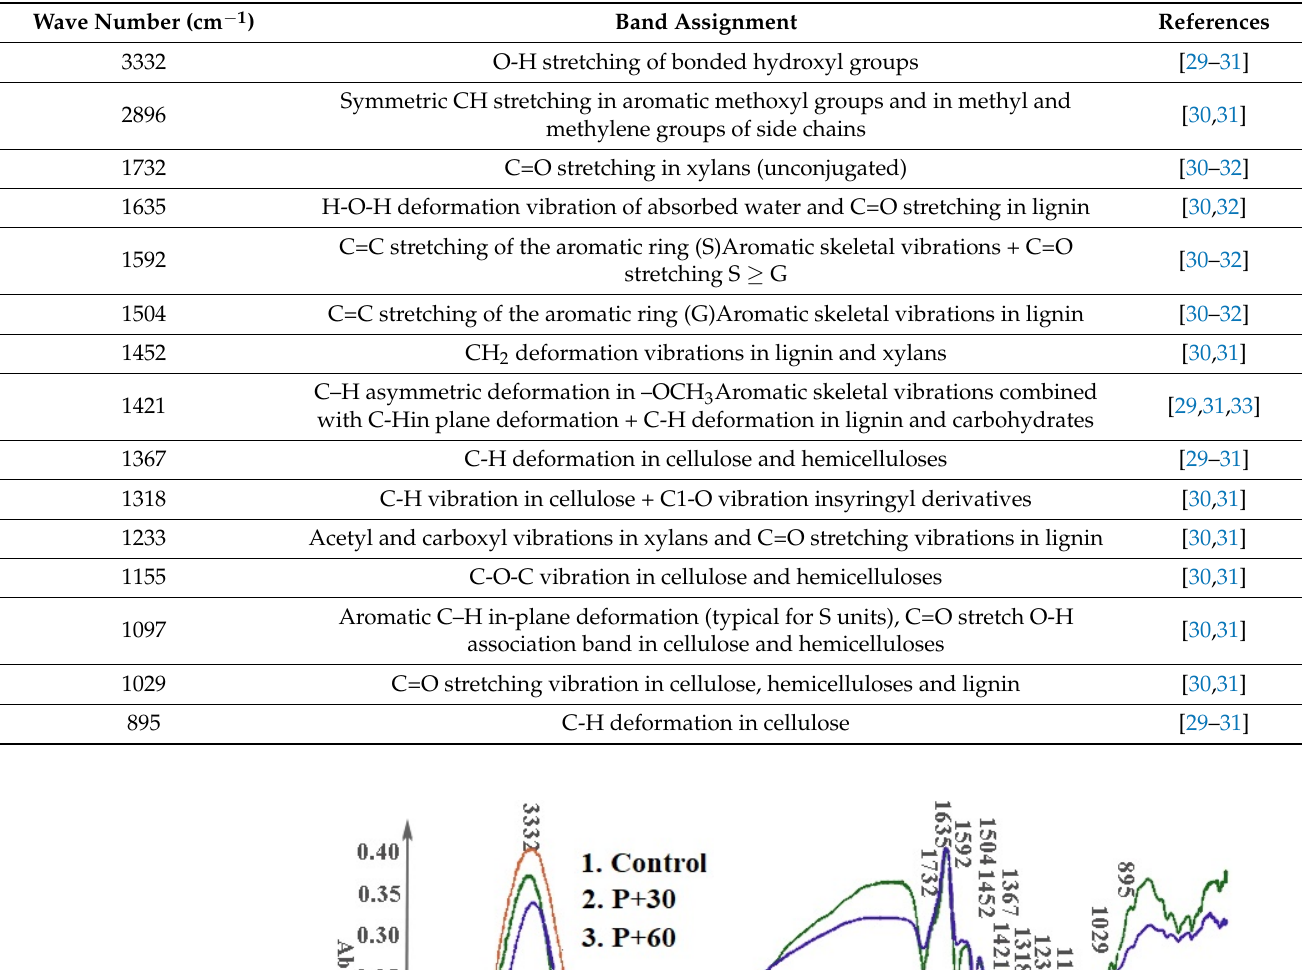
Table 2. Assignments of FTIR peaks to various cell wall polymer components.